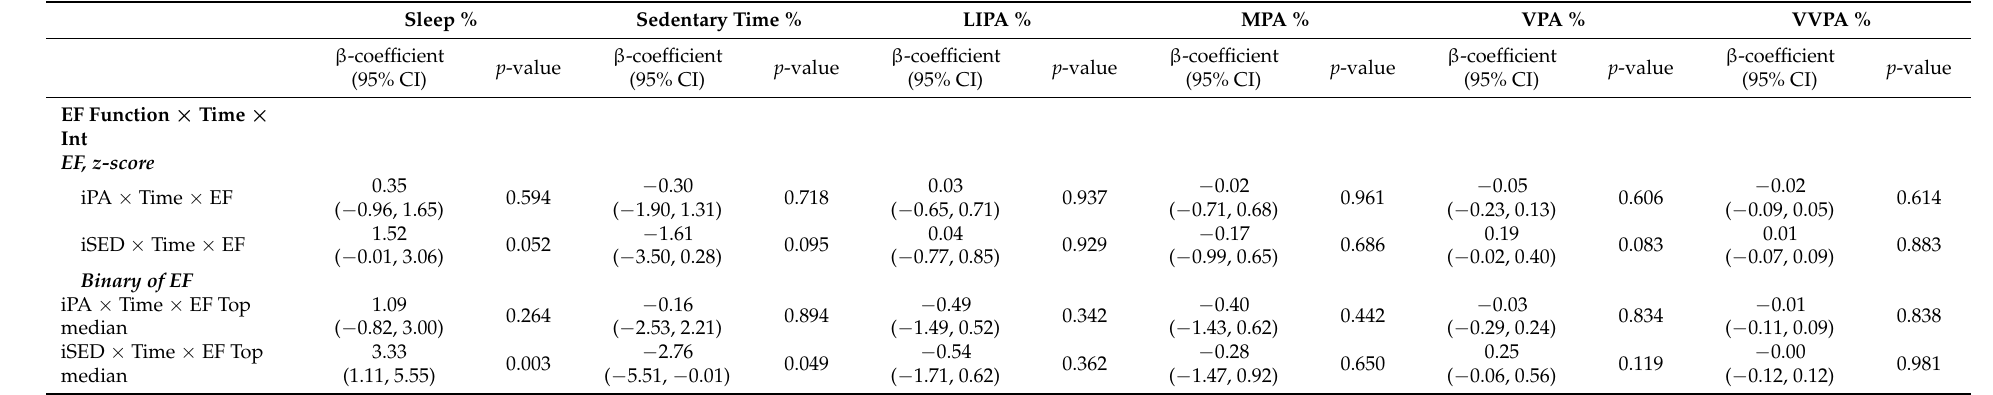
Table 3. The association of executive function with changes in physical activity pattern before and after